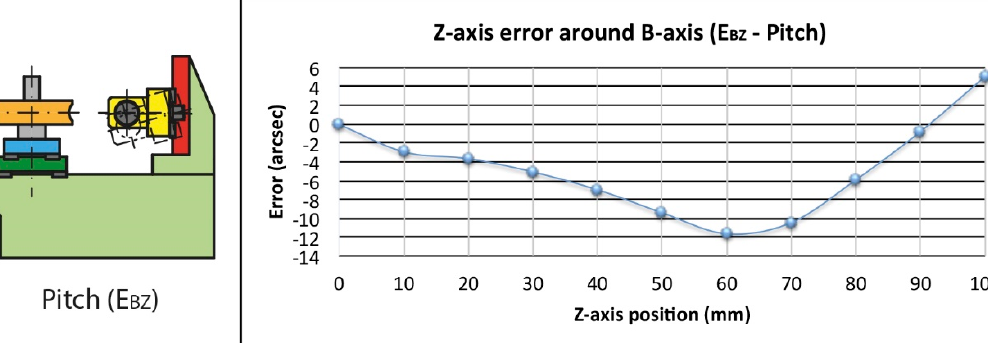
Figure 11. Pitch error (E BZ ) due to displacement of the master worm carriage.